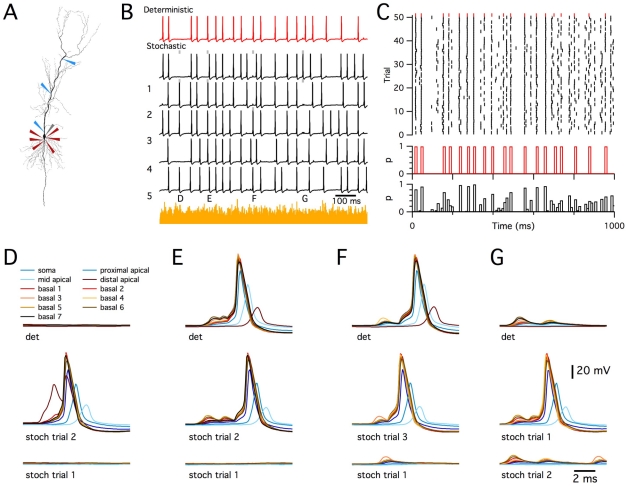
Stochastic ion channels modify synaptically driven spike output from a CA1 pyramidal neuron.(A) Morphology of the simulated CA1 pyrmidal neurons (described in [44]), illustrating positions of recording electrodes placed on the soma (grey), apical (blue) and basal (red) dendrites. (B) Examples of membrane potential responses of the deterministic (red trace) and stochastic (black traces) versions of the model to distributed synaptic input. The summed synaptic current is shown in yellow. Letters and grey bars indicate times of action potentials highlighted in subsequent panels. (C) Spike rasters (top) for responses of the determinisitc model (red) and for 50 consecutive trials of the stochastic model (black) to the synaptic input pattern used in (B). Plotted below is the probability of somatic spike firing in 10 ms duration bins for the deterministic (red) and stochastic (black) versions of the model. (D–G) Examples of determinisitc responses (top row) and representative stochastic respones (lower two rows), illustrating “extra” somatic action potentials triggered by an “extra” actively propagating dendritic spike (D), “dropped” somatic action potentials resulting from failed dendritic depolarization (E–F), and an “extra” somatic action potental resulting from additional dendritic depolarizing potentials.